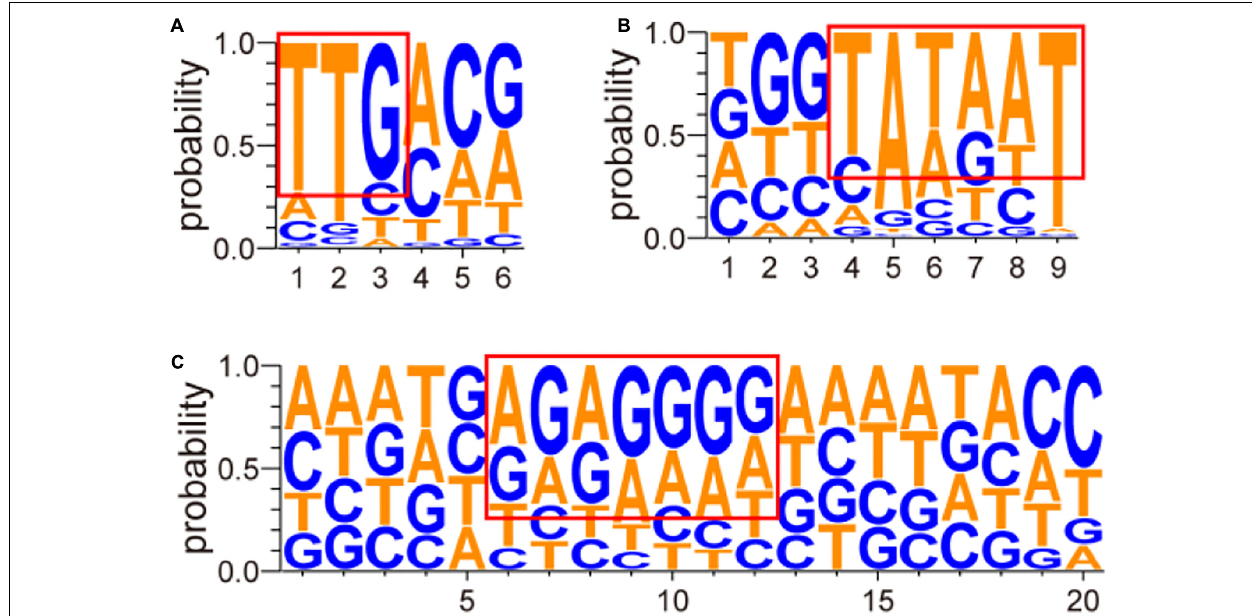
FIGURE 4 | Sequence analysis of conserved nucleotides of screened promoters. The sequence analysis of conserved nucleotides of screened promoters was conducted using Softberry (Salamov and Solovyevand, 2011) and Neural Network Promoter Prediction (Reese, 2001). The abscissa axis shows the positions of nucleotides in different promoters. The 20 nucleotides before the initiation codon “ATG” or “GTG” were selected for the prediction of RBS. The ordinate axis shows the probability of each nucleotide. In the figure, (A) stands for the prediction result of the conserved region near position − 35, (B) stands for the prediction result of the conserved region near position − 10, and (C) stands for the prediction result of the conserved RBS.